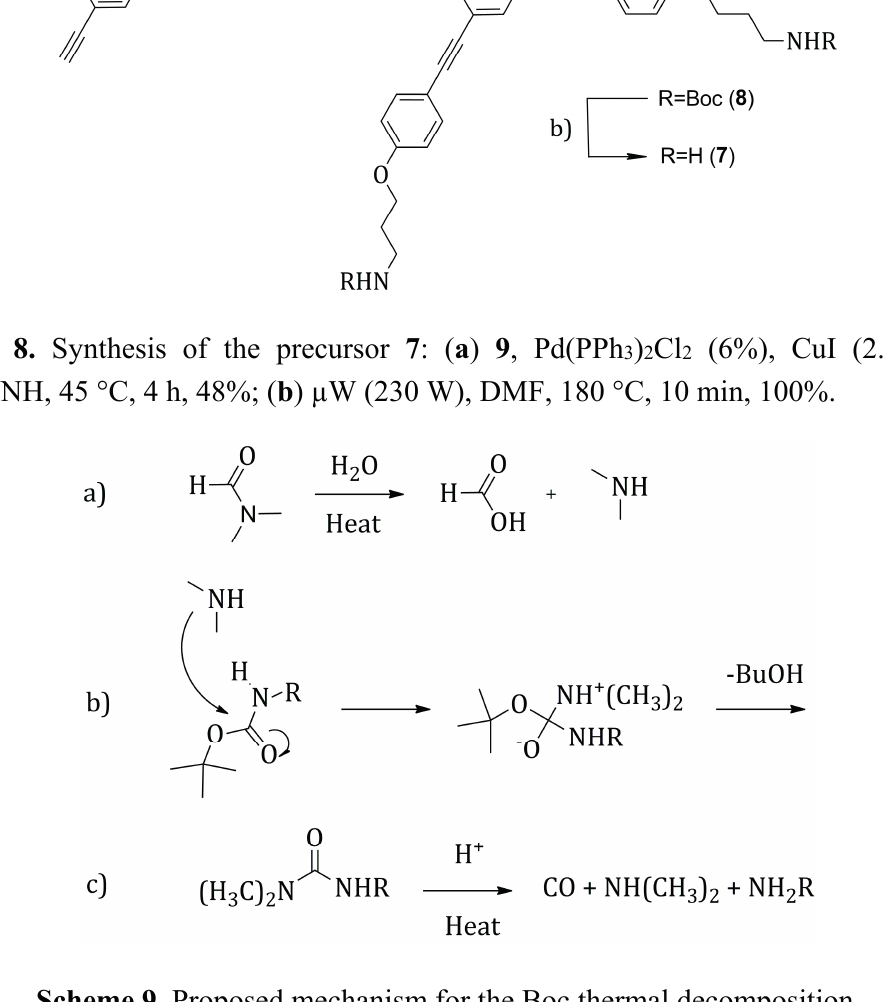
Scheme 9. Proposed mechanism for the Boc thermal